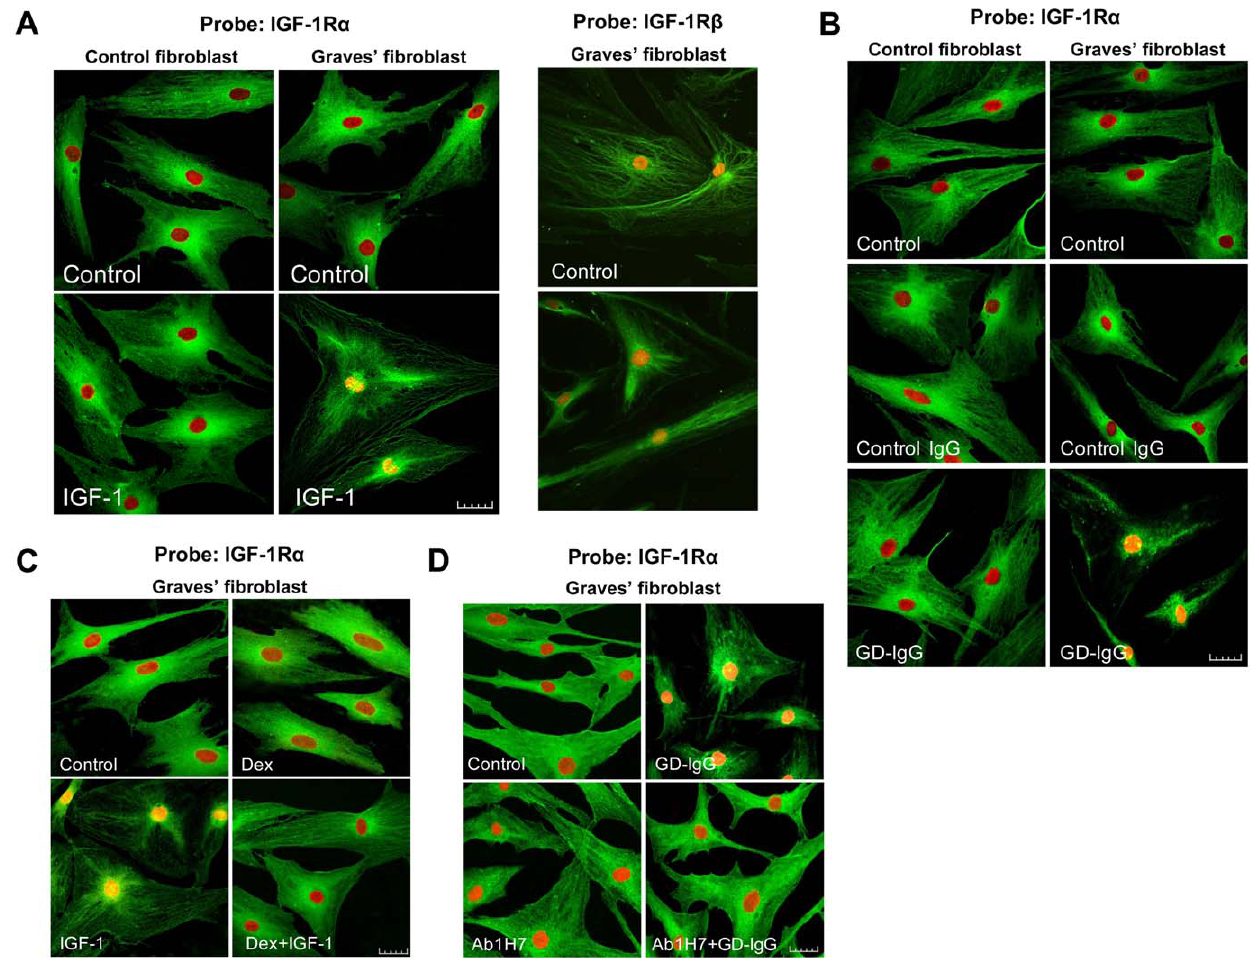
Figure 1. Confocal imaging of IGF-1R reveals nuclear accumulation in TAO fibroblasts following treatment with either IGF-1 or GD- IgG. ( A ) untreated (control, upper panels) or IGF-1 (10 nM) (lower panels) for 16 h. reveals localization of IGF-1R a (green) as indicated by the yellow overlay nuclei in GD fibroblasts. Chromatin was stained by PI (red). Control fibroblasts failed to respond. The images labeled IGF-1R b (green) demonstrate an absence of effects with IGF-1 on nuclear accumulation. Scale bar, 25 m m. ( B ) IGF-1R a (green) co-localizes in the PI-stained nuclei (yellow overlay) following treatment with GD-IgG (15 m g/ml) in GD but not in control fibroblasts. ( C ) Dexamethasone (10 nM) attenuates the nuclear accumulation of IGF-1R a ( D ) as does the IGF-1R-blocking mAb, 1H7 (5 m g/ml). These experiments have been performed 4 times.